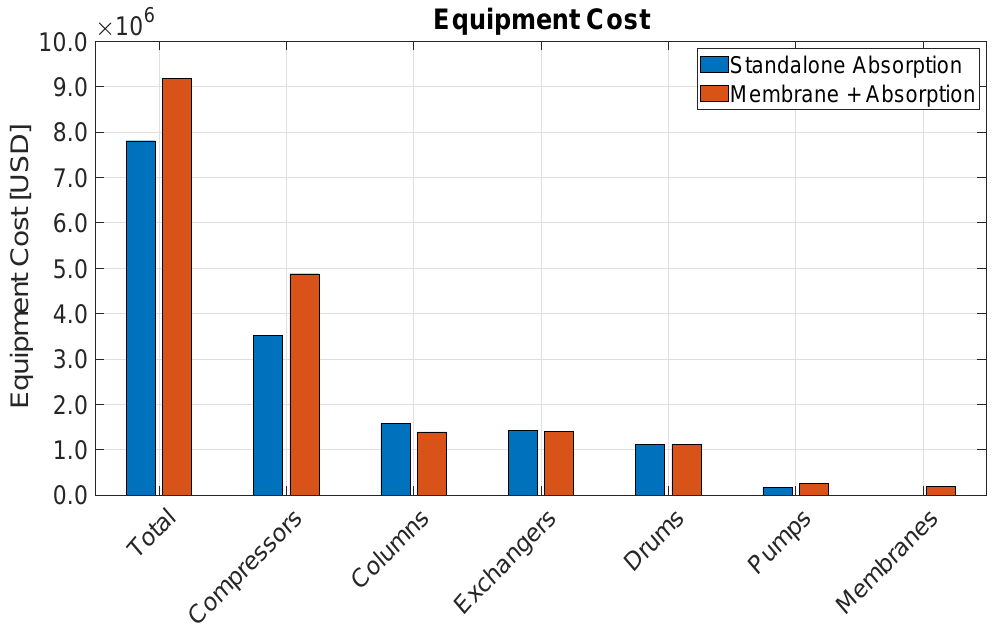
Figure 7. Cost rates of different utility in the CO 2 removal section for the two compared process configurations. Reproduced with permission from Penteado, Ph.D. Thesis, TUB, 2021 [25].